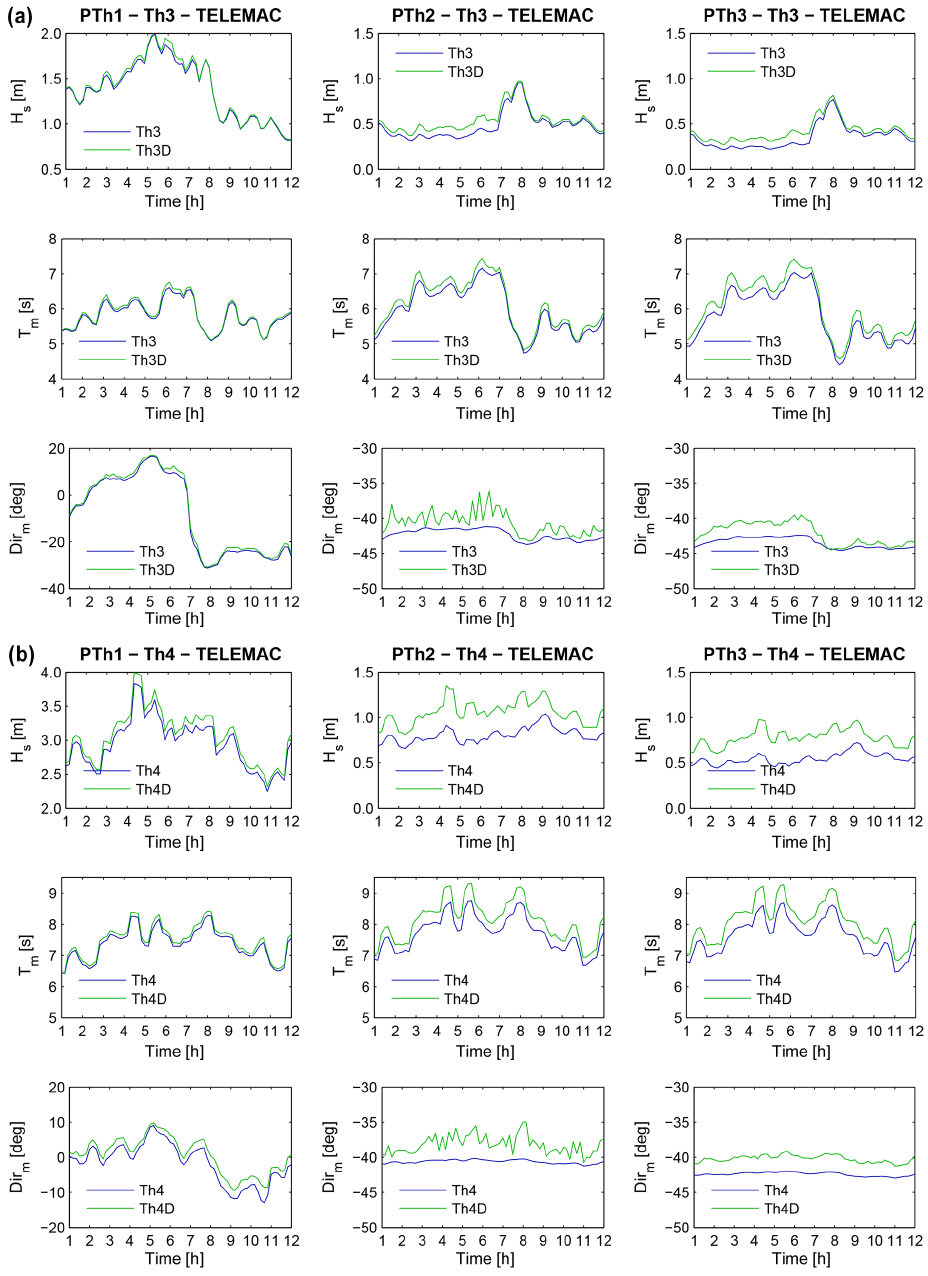
Figure 14. Comparison of TOMAWAC results ( H s − T m − Dir m ) for the Bari case study at points PTh1, PTh2 and PTh3 for forcings (a) TS1 and (b)